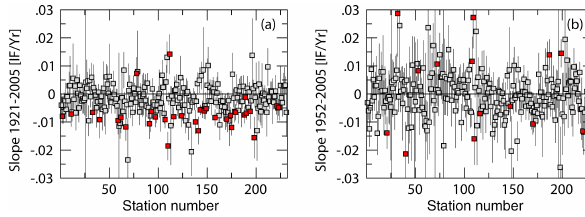
Figure 6. Trend slopes with 1-sigma error bars relative to (a) the full record period and (b) a relevant sub-period (1952–2005), for any station site in both cases. Red symbols denote significant trends ( p value<0.05) according to a Mann–Kendall